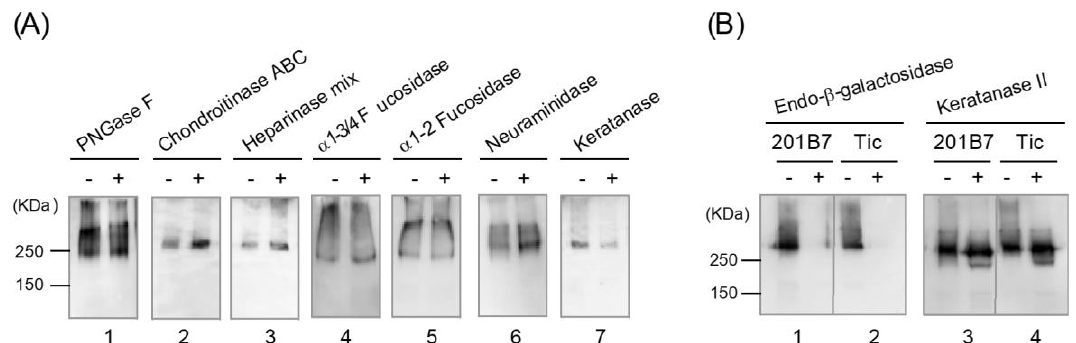
Figure 4. Characterization of the purified R-10G-binding protein by glycosidase digestion and Western blotting. Puri- fied R-10G-binding protein (0.5–4 ng) incubated with (+) or without ( − ) glycosidases was subjected to SDS-PAGE on a 4–15% gradient polyacrylamide gel under non-reducing conditions. The exception was PNGase F digestion, which requires preheating under reducing conditions. Western blotting using R-10G was subsequently conducted. ( A ) Purified R-10G-binding protein from 201B7 cells was digested with PNGase F (lane 1), chondroitinase ABC (lane 2), a heparinase mixture (lane 3), α 1-3/4 fucosidase (lane 4), α 1-2 fucosidase (lane 5), neuraminidase (lane 6), and keratanase (lane 7), and the digests were analyzed by Western blotting using R-10G. ( B ) Purified R-10G-binding protein from 201B7 (lanes 1, 3) and Tic (lanes 2, 4) cells incubated with (+) or without ( − ) endo- β -galactosidase (lanes 1, 2) or keratanase II (lanes 3, 4) was analyzed by Western blotting using